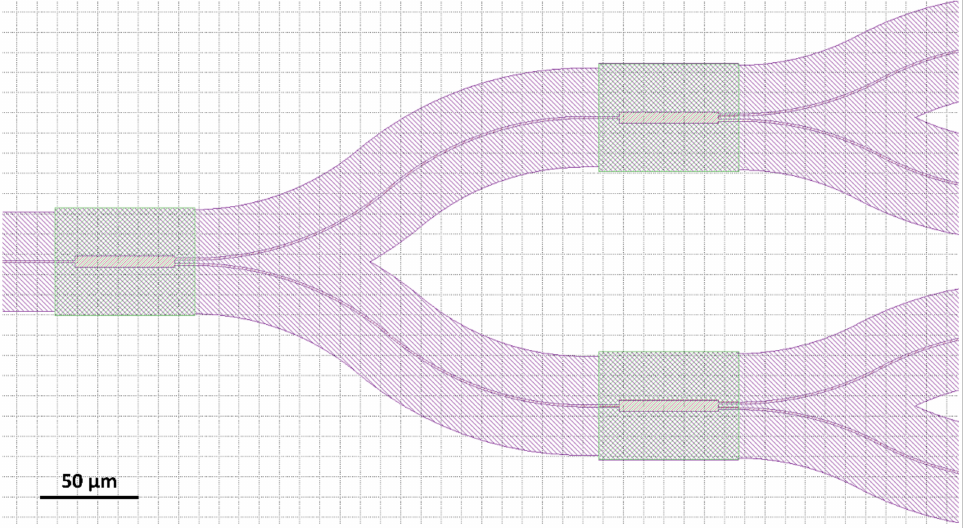
Figure 20. Topography of test structure comprising three 1 × 2 MMIs designed for λ = 660